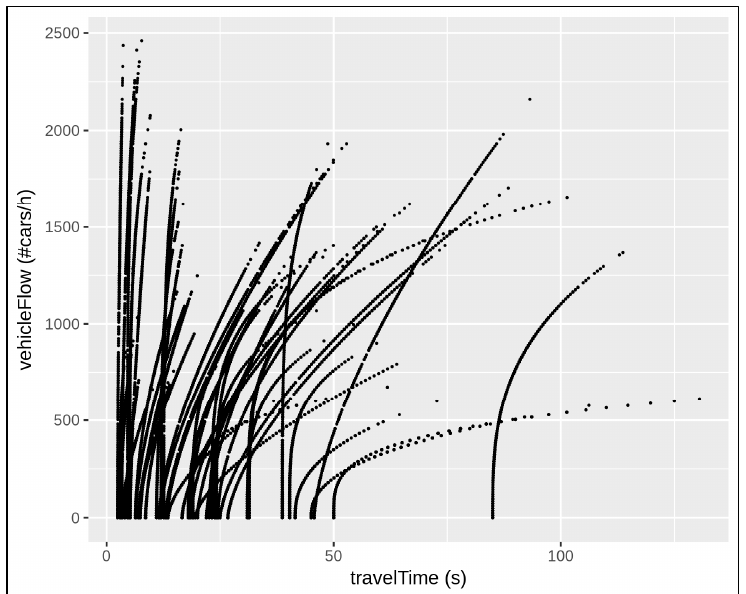
Figure 3. The collection of monitored traffic data coming from about 50 traffic sensors at sparse locations in the network over 7 days of observation. Each traffic sensor location presents a specific traffic behaviour depending on the travel time.